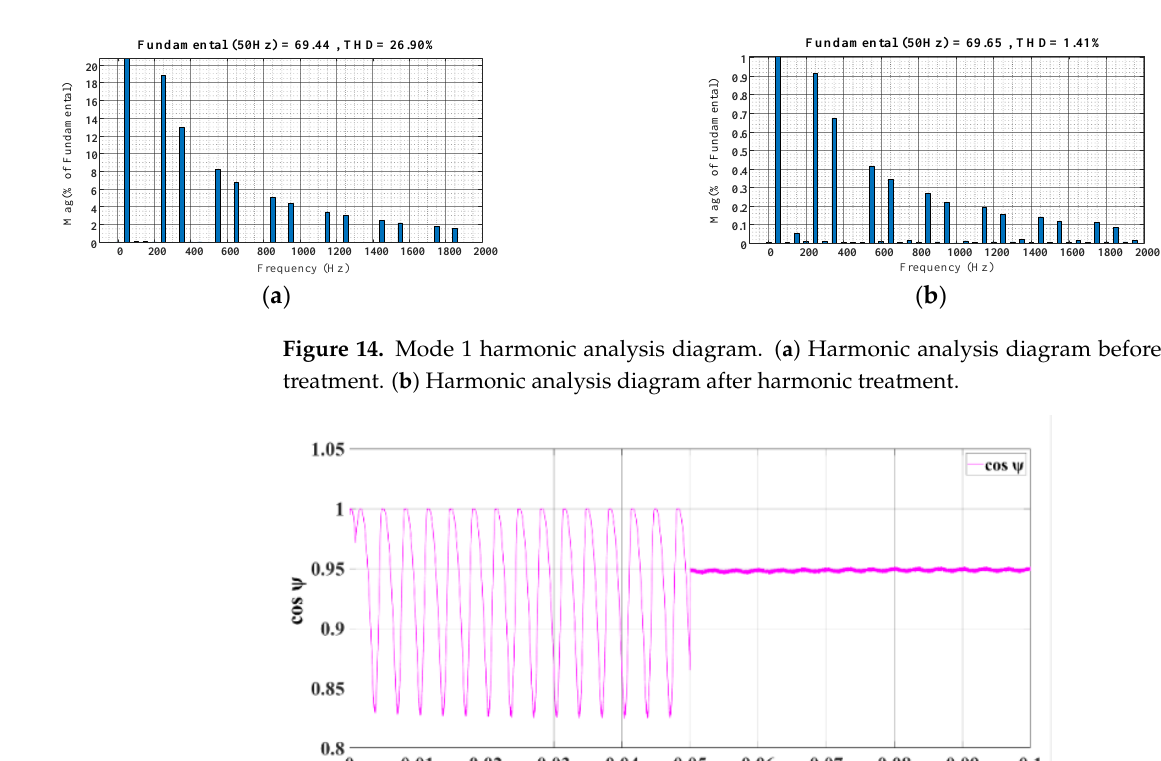
Figure 13. Mode 1 grid current diagram.